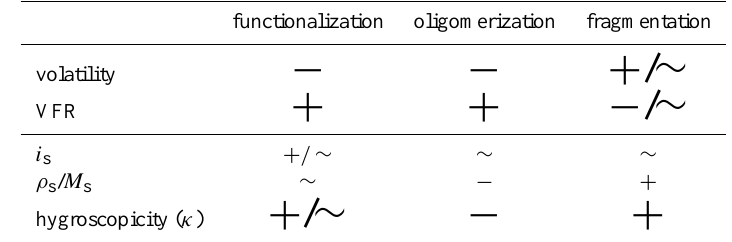
Table 1. The three main chemical processes and their expected influence on volatility and hygroscopicity, and on additional parameters: van’t Hoff factor i s ; the ratio of density to molar weight of solute, ρ s / M s . Symbols represent: + expected to increase, − expected to decrease, ∼ only minor change expected. For hygroscopicity ( κ ) see also Eq. (1). Note that if the chemical processes result in a substantial aerosol mass gain, then the resulting changes of particle volatility and hygroscopicity are determined by the relative difference between the properties of the previous and added SOA mass, and consequently the trends indicated in Table 1 are not